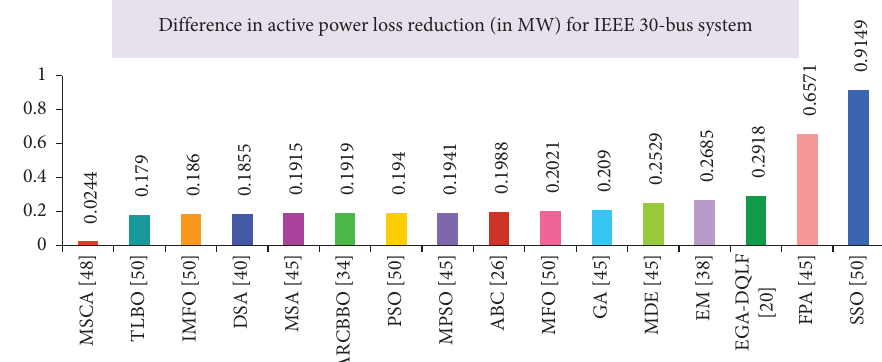
Figure 4: Diference in the active power loss reduction (in MW) of the proposed technique against other optimization methods reported in the literature for the IEEE 30-bus